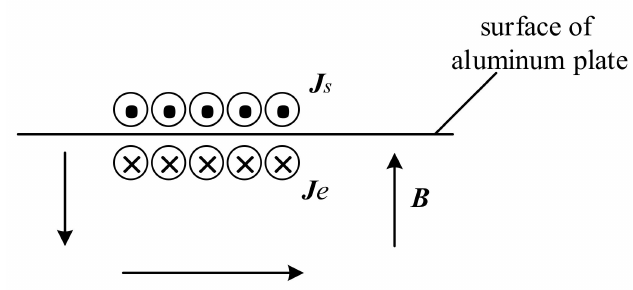
Figure 1. Mechanism of an EMAT in the aluminium